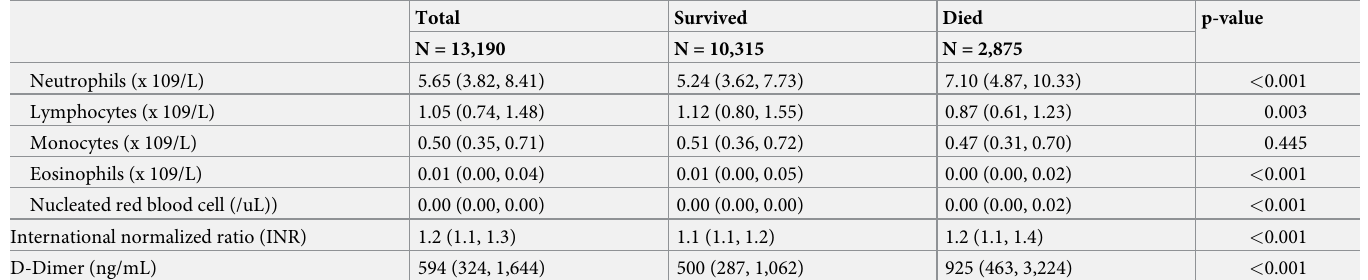
PLOS ONE | https://doi.org/10.1371/journal.pone.0269813 July 29,